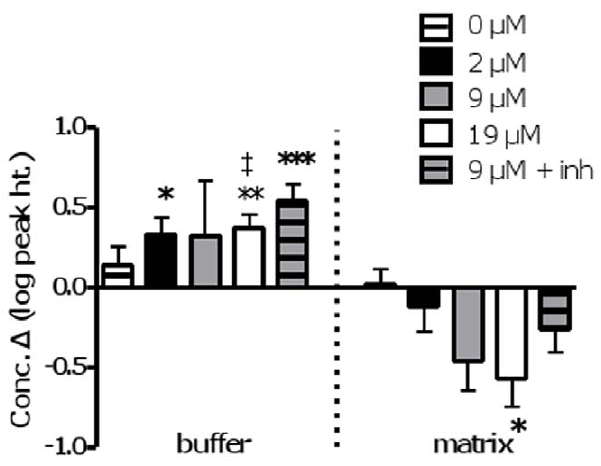
Figure 7. Changes in 3-hydroxybutanoic acid over time in buffer and matrix fractions obtained from muscle mitochon- drial preparations. Significance: paired t-test, 0 vs . 20 min, within treatment; * P , 0.05; **, P , 0.02, *** P , 0.005. { : indicates that an outlier was removed. See legend to Figure 5 for further details.